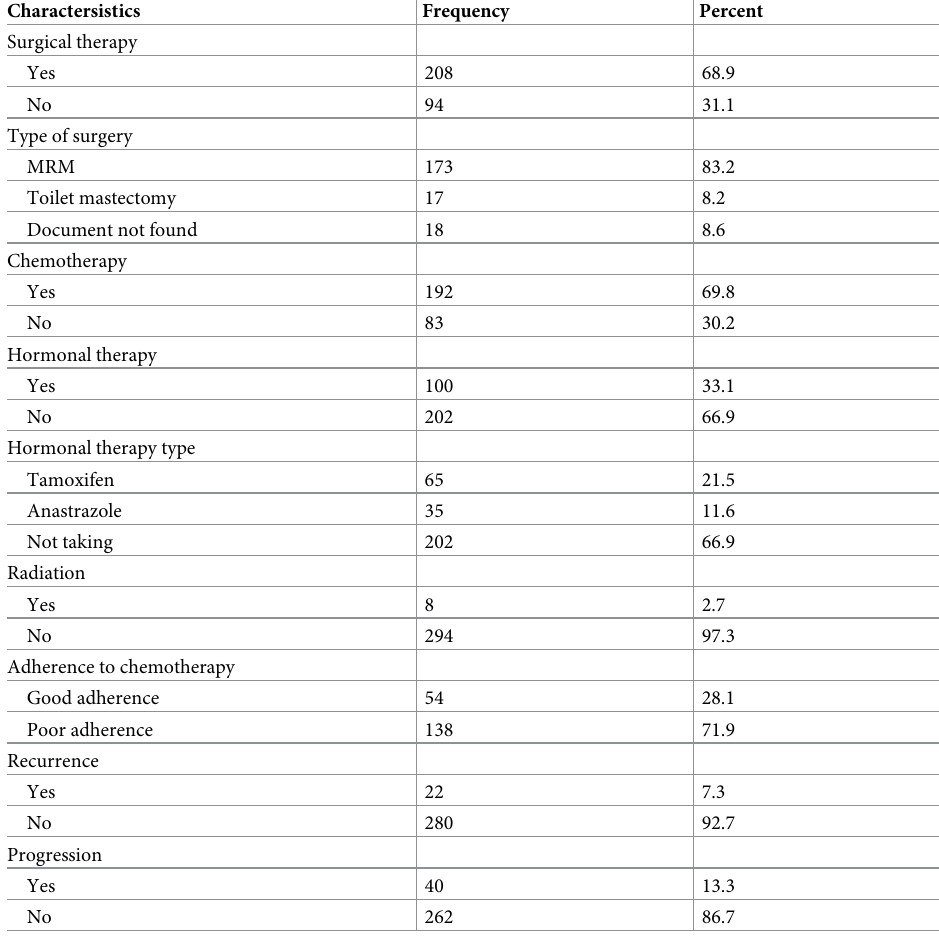
Table 2. Treatment characteristics of female breast cancer patients in southern Ethiopia, 2013–2018 (n = 302). Charactersistics Frequency